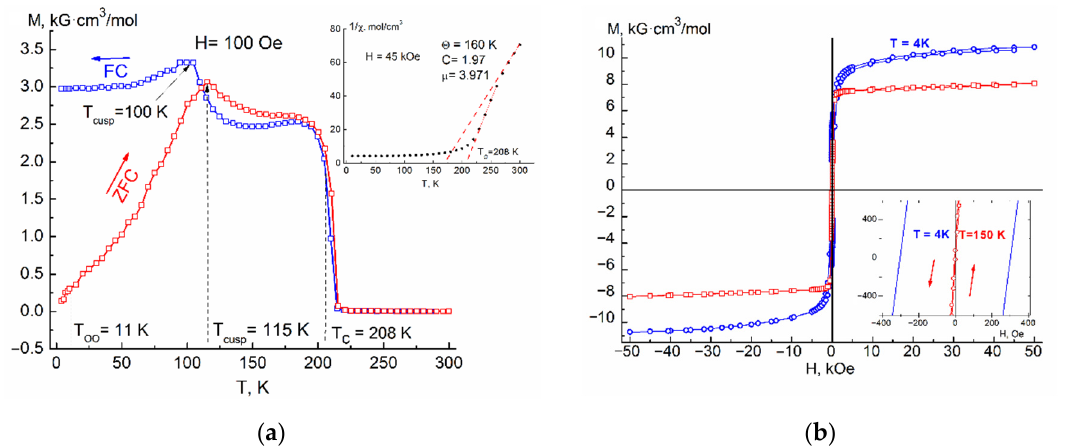
Figure 2. ( a ) Dependences of the M vs. Т of FC and ZFC magnetization for Fe 0.90 Ag 0.10 Cr 2 S 4 in a 100 Oe field. Inset: dependence of the inverse magnetic susceptibility versus temperature for this com- position. ( b ) Dependences of the magnetization versus magnetic field for Fe 0.90 Ag 0.10 Cr 2 S 4 at 4 and 150 K.